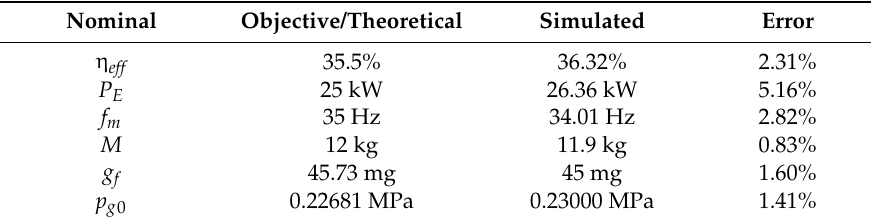
Table 8. Objective and simulated specifications.